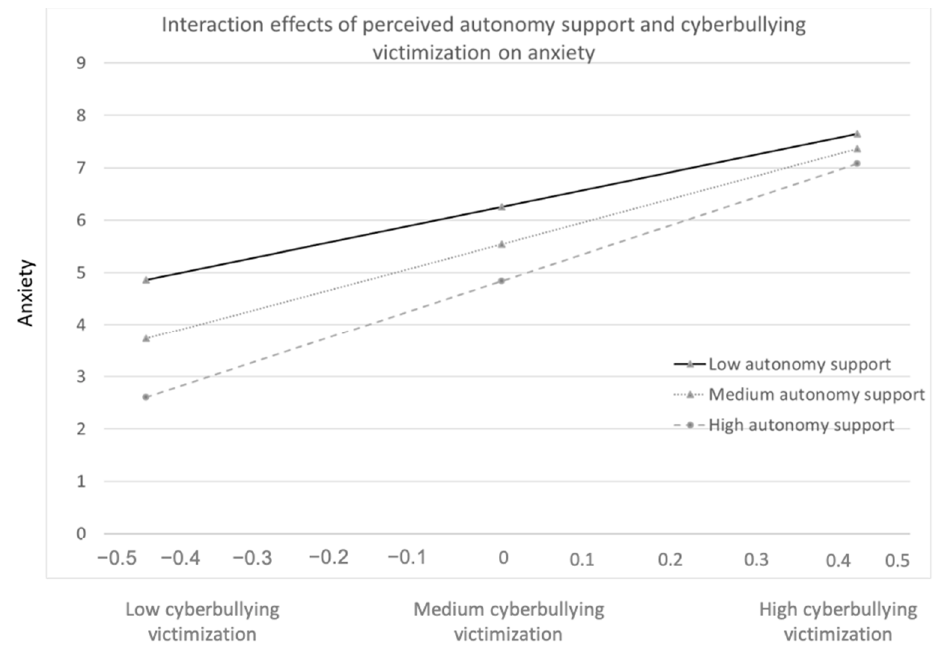
Figure A3. Interactions between autonomy support, cyberbullying victimization, and depressive symptoms.